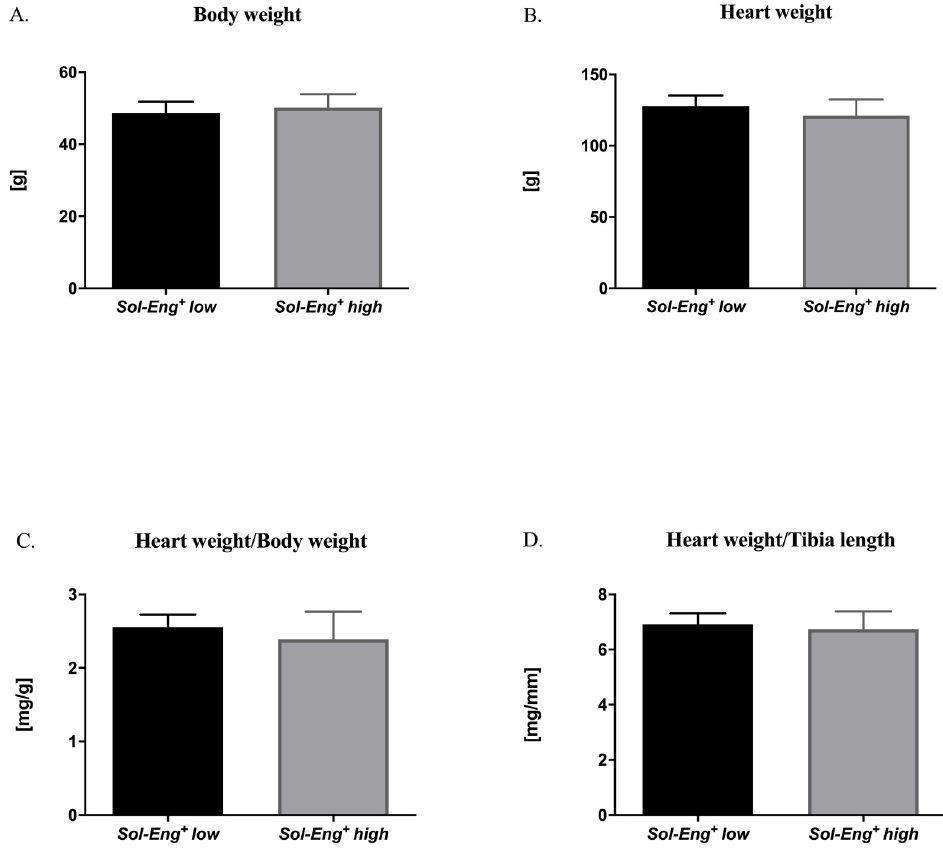
Fig 2. Body weight, heart weight and tibia length of Sol-Eng + mice. Body weight (A), heart weight (B), heart weight/ body weight ratio (C) and heart weight/tibia length ratio (D). Data are shown as mean ± S.E.M., Mann-Whitney test. n = 8 mice per